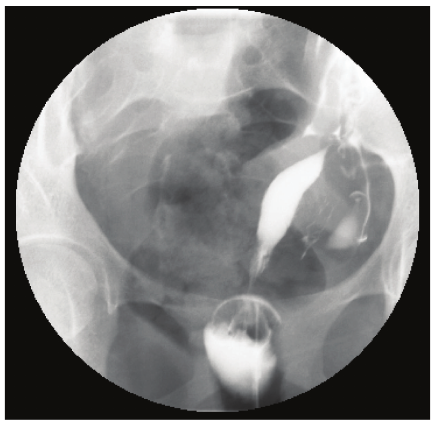
Figure 1: Preoperative MRI showing fetus in right uterine horn with no visible channel between left and right uterine horn.